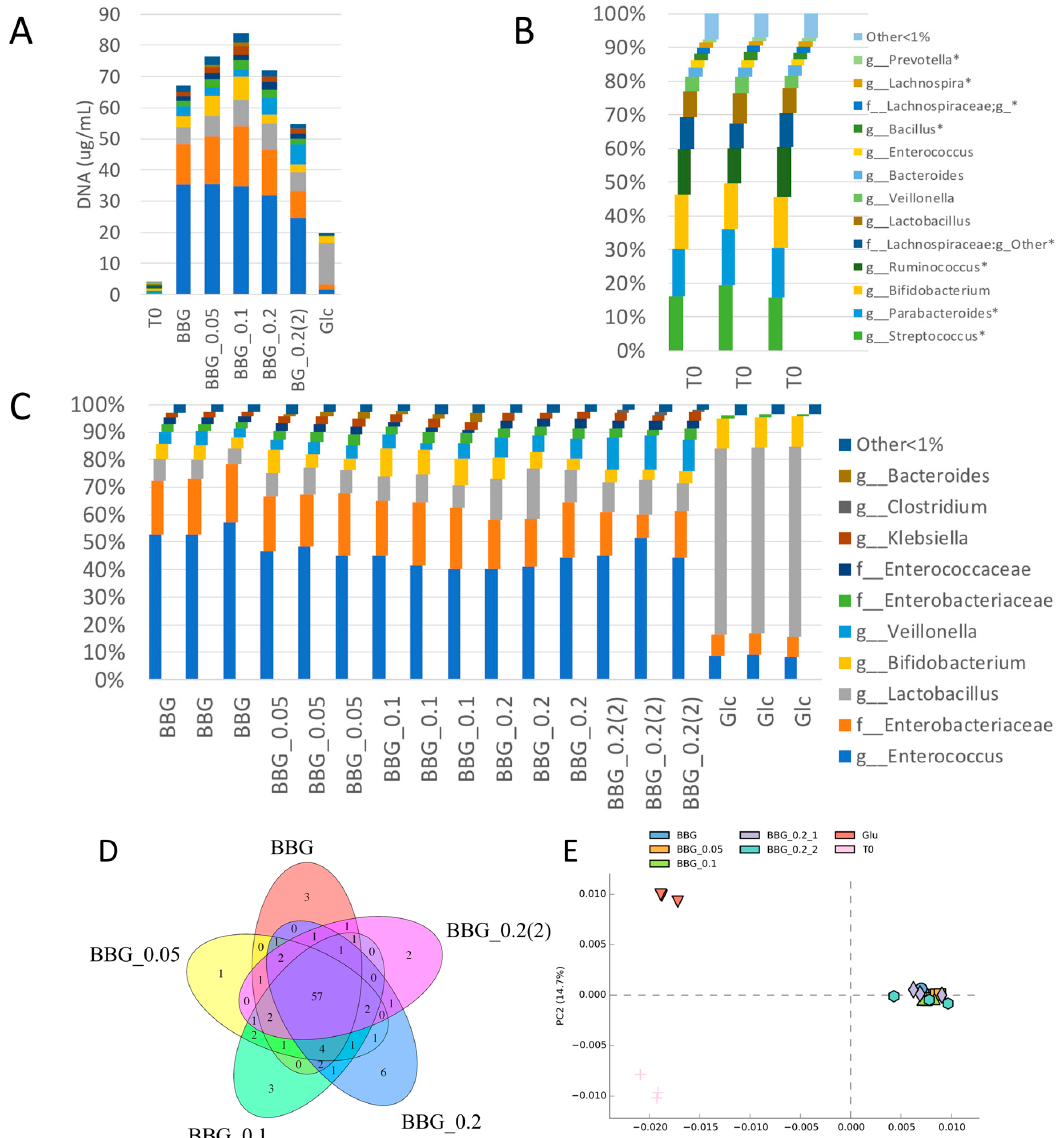
Figure 3. 16S amplicon sequencing results of fermentation of BBG samples by infant faecal inoculum. ( A ) Bar plot of the major identified bacterial taxonomy scaled to the total extracted DNA concentration, noted as quasi-absolute bacterial amount; ( B ) Enlarged view of the relative abundance of the taxon >1% of T0 group at the beginning of fermentation; ( C ) Enlarged view of the relative abundance of the taxon >1% of the five BBG groups and glucose monomer, Glc; ( D ) Venn diagram showing the similar and different number of bacteria taxonomy identified; ( E ) β -diversity analysis showing the principle component analysis of the five BBGs and glucose monomer.